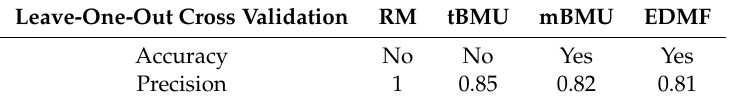
Table 13. Accuracy and precision established using a leave-one-out cross-validation approach for Scenario 3, involving ten deflection measurements. Precision is the mean value over the ten measurement locations, while accuracy needs to be validated over all measurement